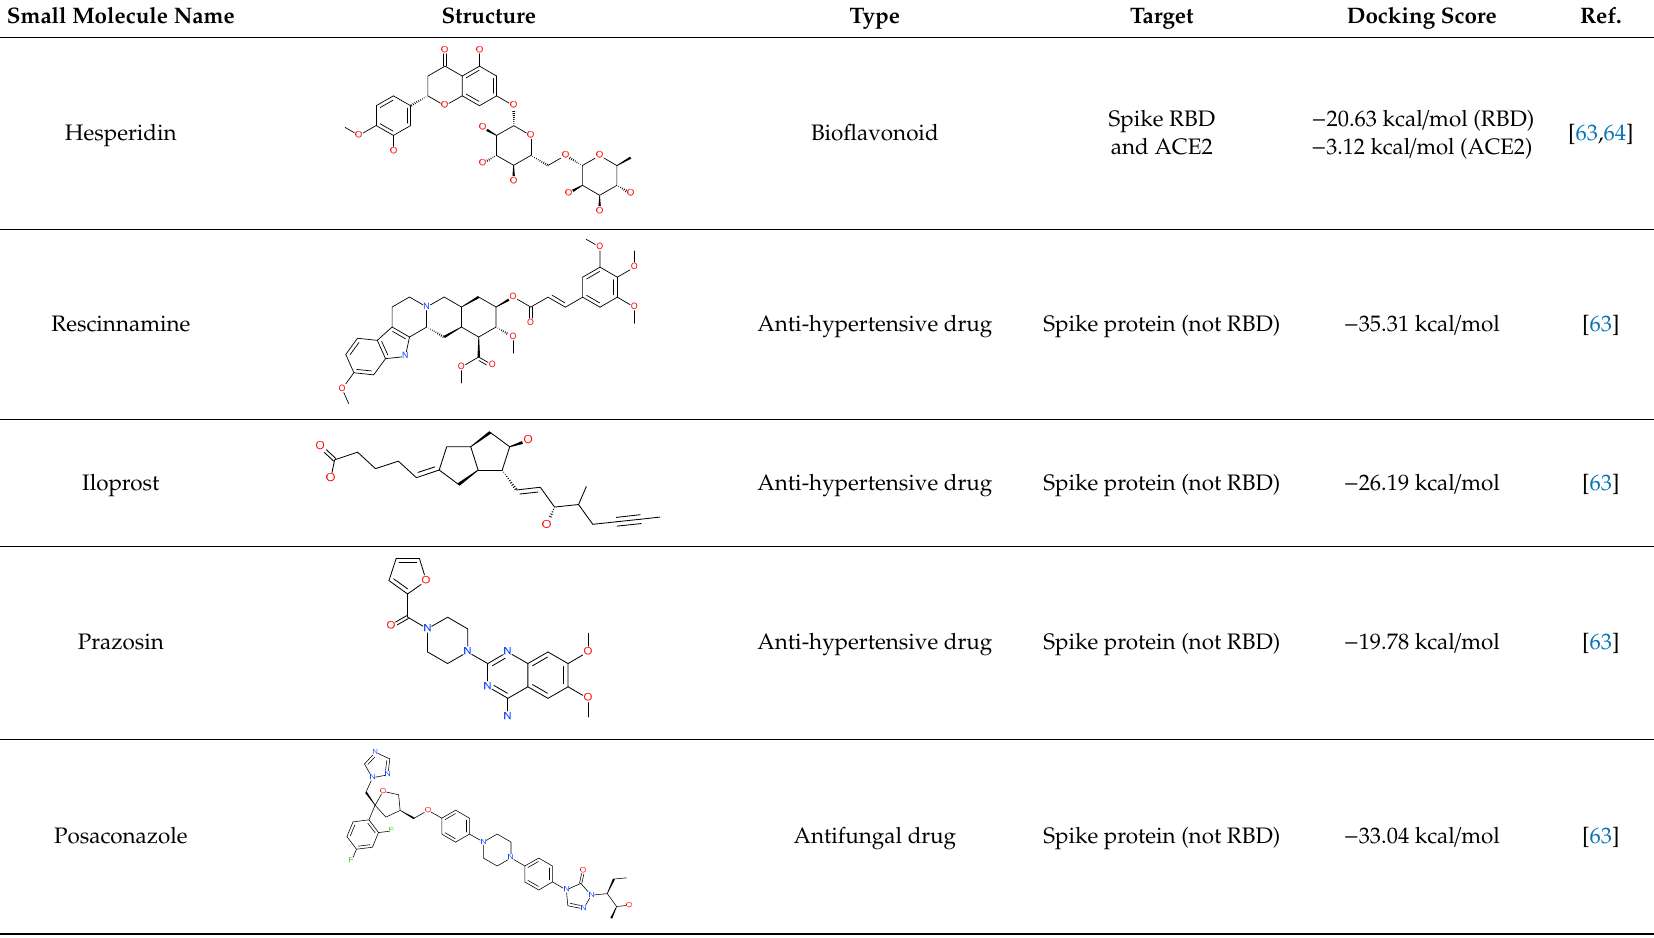
Table 3. Small molecules identified through computational approaches for targeting SARS-CoV-2 spike